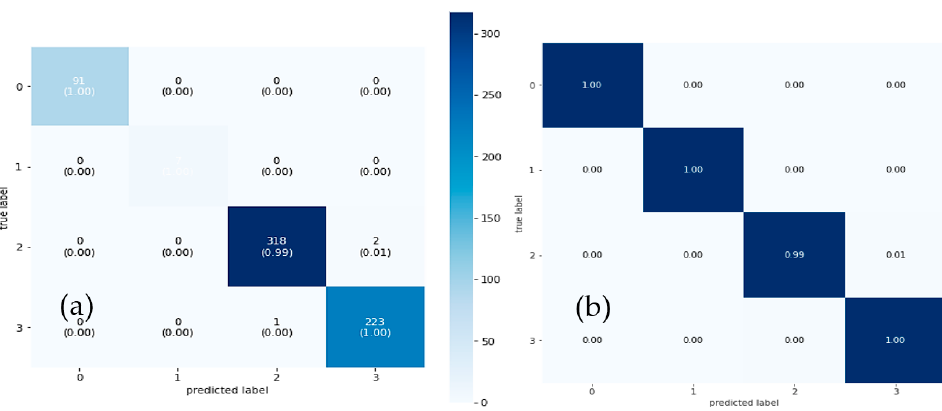
Figure 7. An example of confusion matrix of proposed CAD-ALZ system to recognize all stages of